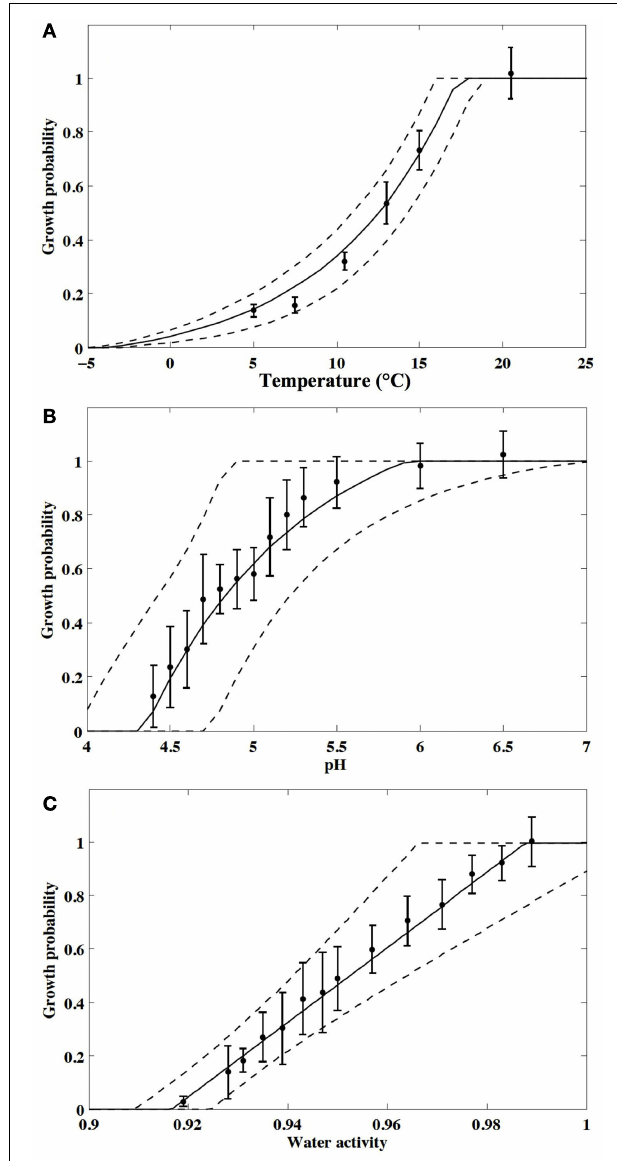
FIGURE 1 | Evolution of the single-cell growth probability of L. monocytogenes inTSBye according to (A) the temperature, (B) the pH, (C) the water activity. Points represent the mean of the observed probabilities and vertical bars represent the SD. Lines are the fitted models, solid lines correspond to the median behavior and dashed lines represent the 2.5th and 97.5th percentiles of variation.